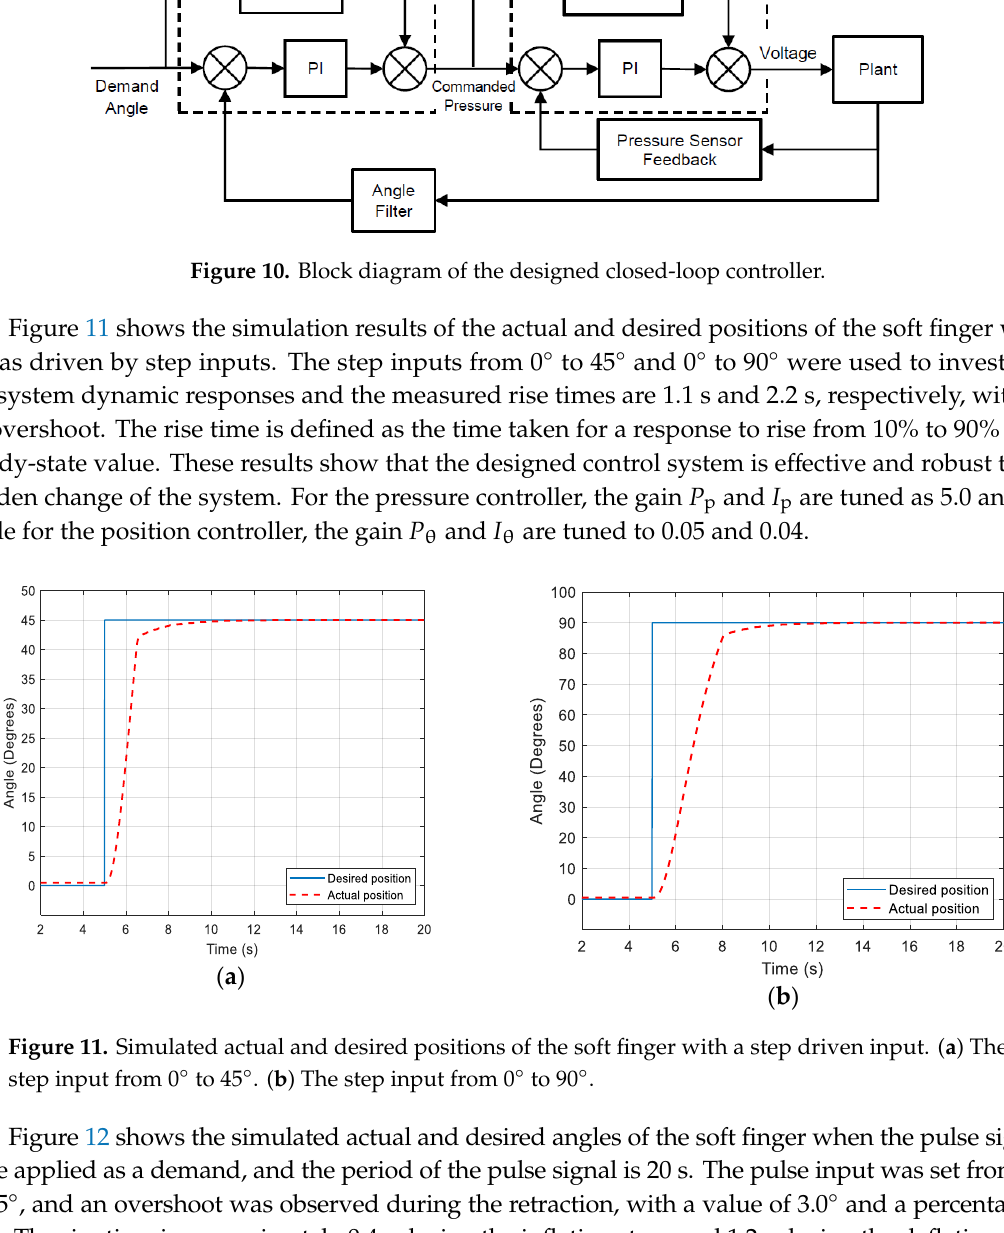
( b ) Figure 12. Simulated actual and desired positions of the soft finger with a pulse driven input (pulse period = 20 s). (a) The pulse input from 20˚ to 45˚. (b) The pulse input from 20˚ to 90˚. Simulated results show that the designed control system is effective to control the self-sensing finger actuator using a feedback control configuration. This demonstrates the feasibility of manufacturing and using a self-sensing actuator as a sensor for the development of a control system, which contributes to the development of a soft controllable self-sensing actuator. Further investigation will consider increasing the accuracy and robustness of the self-sensing measurement and reducing resistance drift during measurement. However, this could be overcome if the change of the resistance Δ R is consistent, which could be employed in the control system instead of using the absolute resistance measurement R directly.